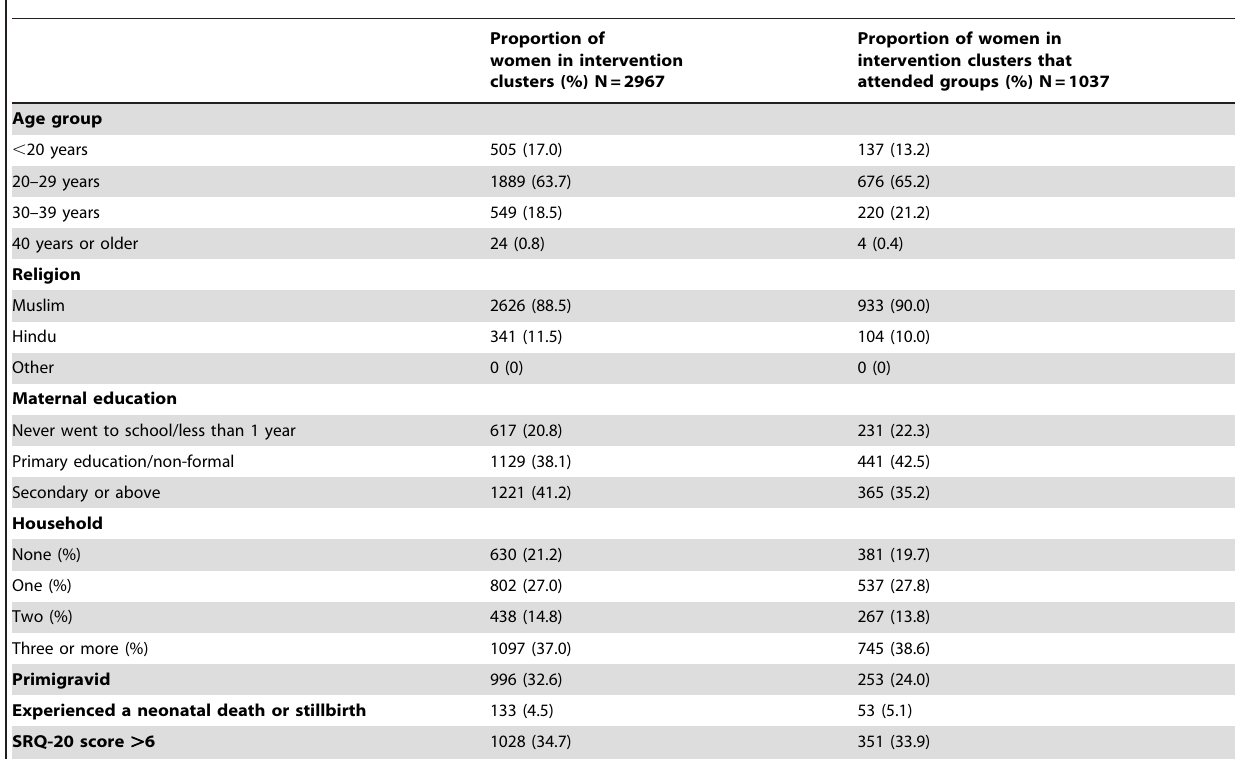
Table 2. Women’s group participation rates among respondents screened with the